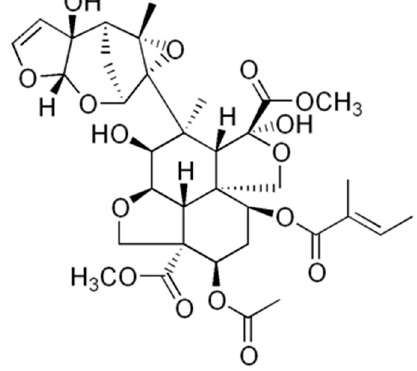
Figure 8. Corrosion potential of the carbon steel rods.